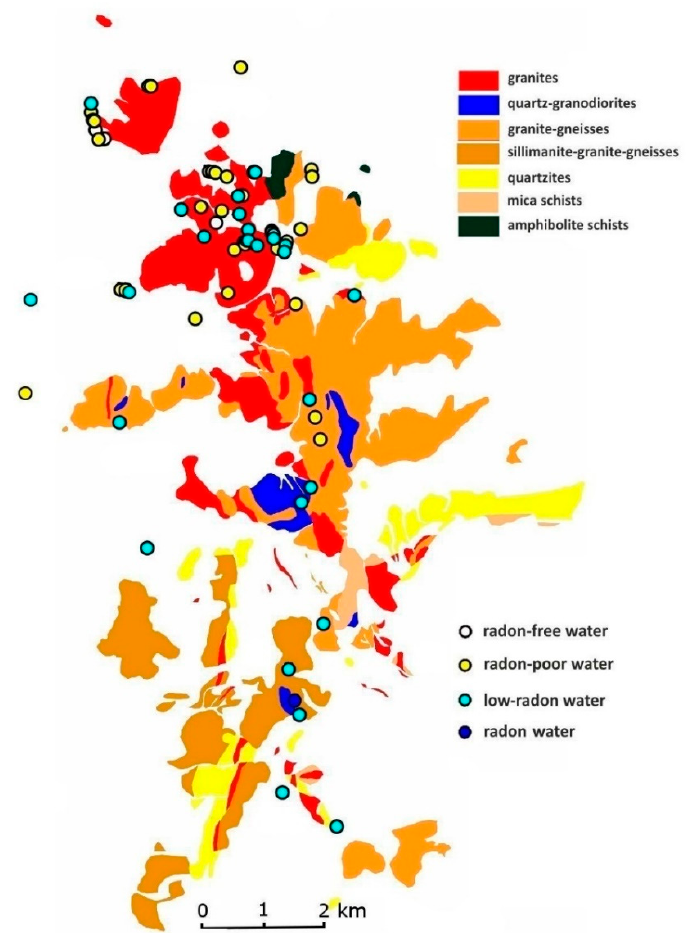
Figure 4. Strzelin granitoids. Groundwater sampling sites plotted together with the types of collected water by 222 Rn content according to Przylibski’s classification [2].